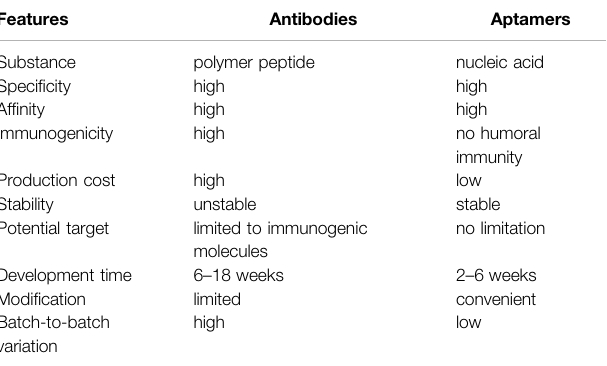
TABLE 2 | The characteristics comparison of nucleic acid aptamers and antibodies (Jayasena, 1999; Zhou and Rossi, 2017; Zhuo et al., 2017; Yu et al.,